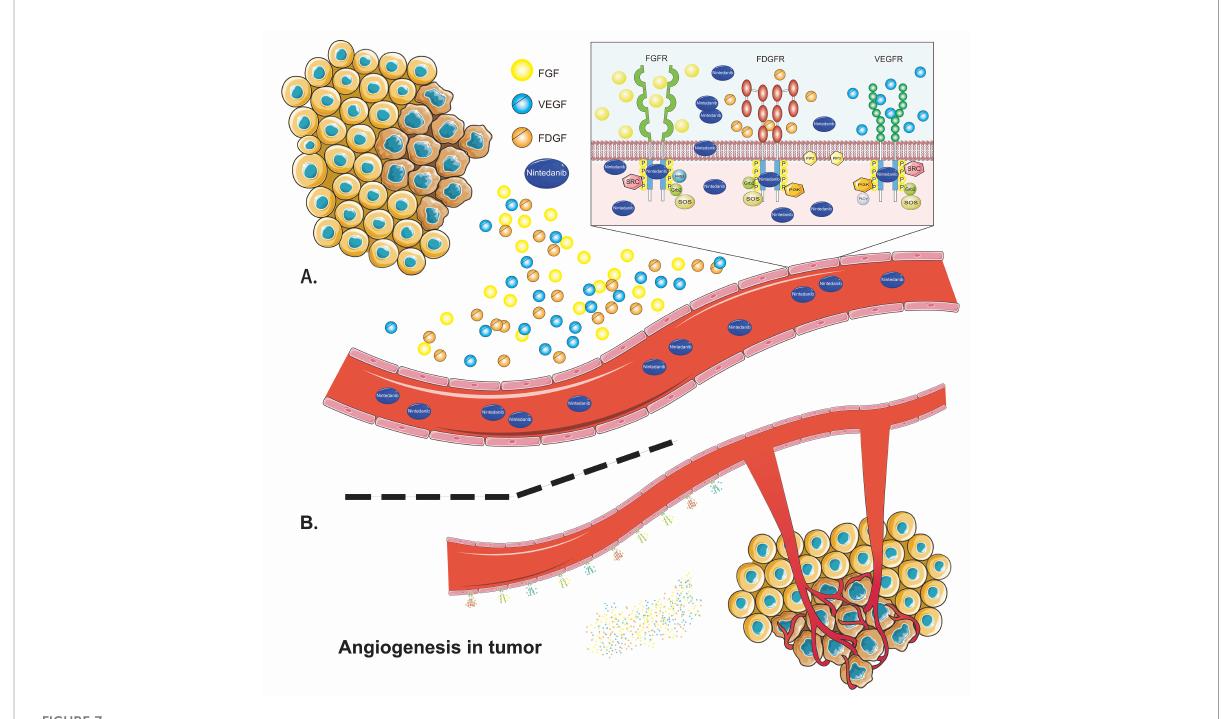
FIGURE 7 The basic mechanism of